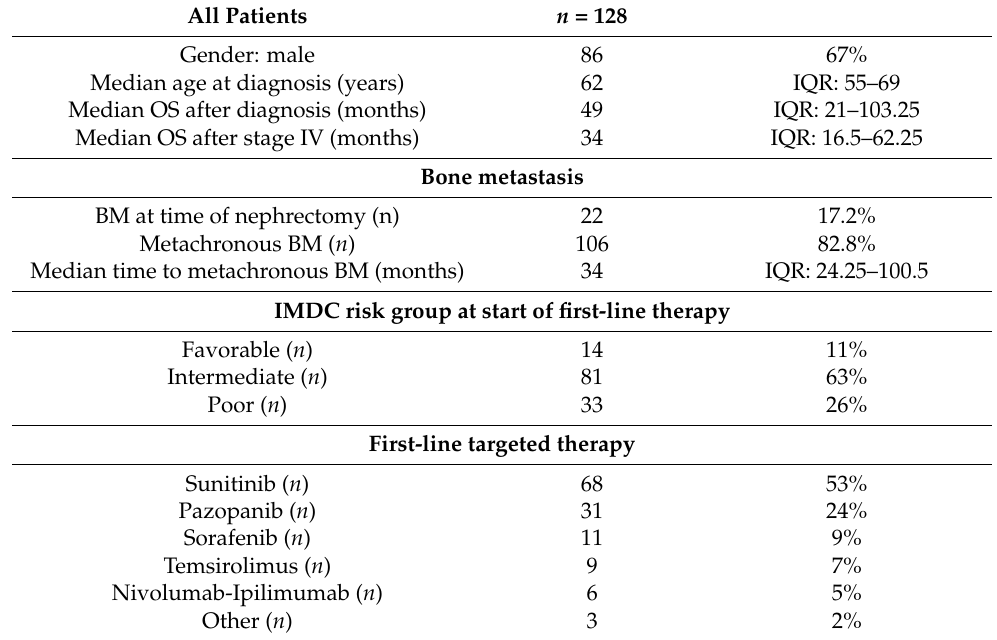
Table 2. Patient